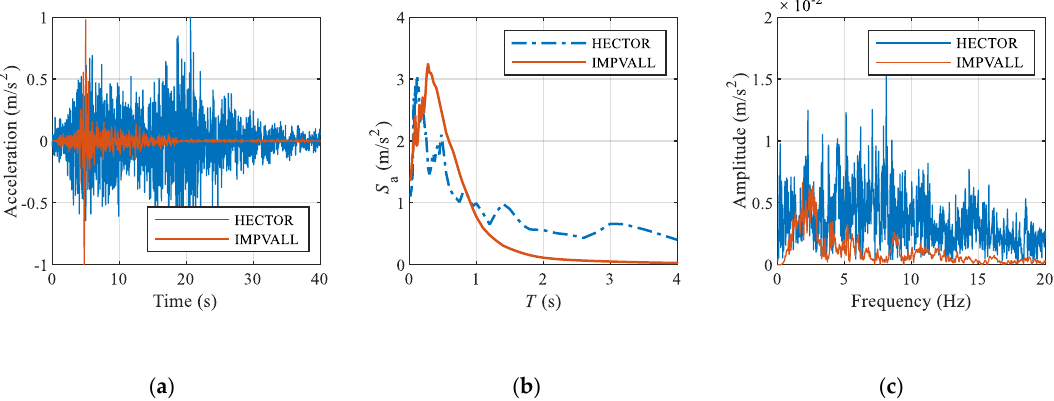
Figure 4. Comparison of ground motions: ( a ) Acceleration time histories; ( b ) acceleration response spectra; ( c ) frequency spectra.